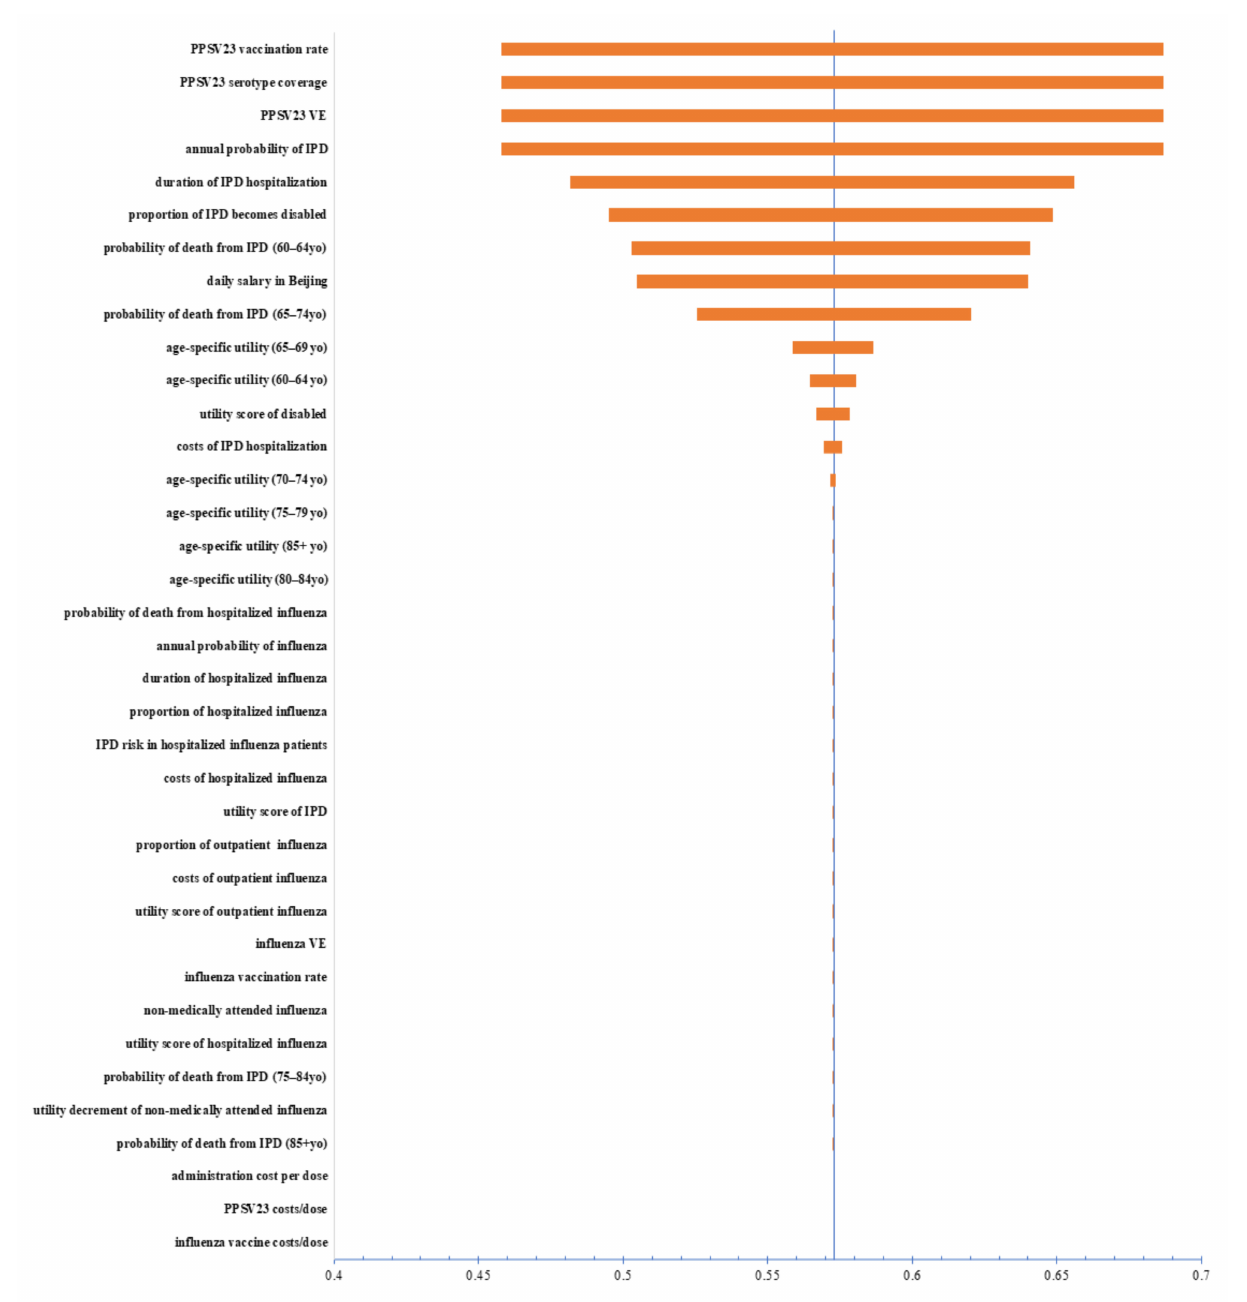
Figure 2. The NMB changes of strategy 4 compared with those of the current policy (strategy 3) in OWSA. PPSV23, pneumococcal polysaccharide vaccines; IPD, invasive pneumococcal disease; VE, vaccine effectiveness; YO, years